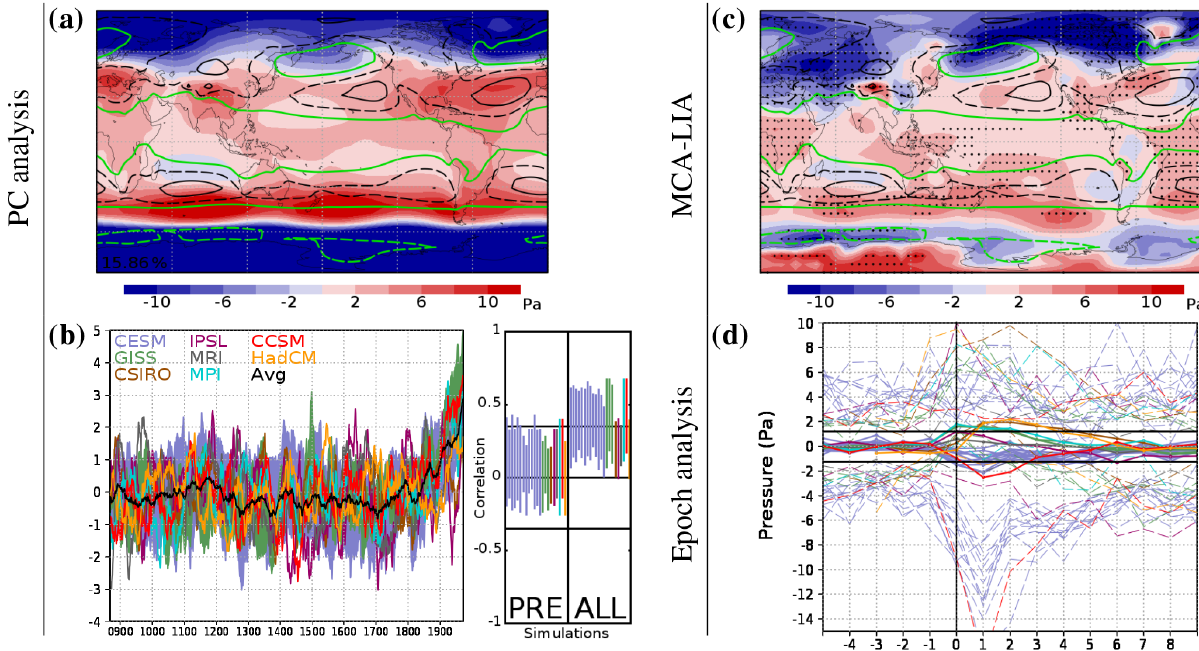
Figure 4. Analysis of SLP for the ensemble of simulations included in Table 1. (a) First EOF and (b) first PC time series for each simulation, as well as the average PC of all the simulations (black line). The percentage of explained variance is shown within the EOF map. The range of correlations between the PC of each simulation and those of other simulations is also included on the right of the plotted PCs both for the whole period (ALL) and for the preindustrial era (PRE). For these correlations, the significance level ( p < 0 . 05) accounting for autocorrelation is shown with a black line. (c) Map of SLP differences between MCA and LIA. Dots indicate locations where the differences are significant ( p < 0 . 05). Contours with climatological SLP of 986hPa (dashed green), 1012hPa (solid green), 1016hPa (dashed black), and 1020hPa (solid black) are included in the EOF and MCA–LIA maps. (d) Composite average (solid lines) and maximum and minimum (dashed lines) global SLP anomalies in the 5 years before and 10 years after the 12 main volcanic eruptions of the LM. The vertical line indicates the year of the volcanic event. The horizontal black lines show the significance level of the average ( p < 0 . 10) based on the distribution of averages of 12 years generated with 2200 sets randomly taken from the whole period excluding the years of the 12 main volcanic eruptions and the 10 years after